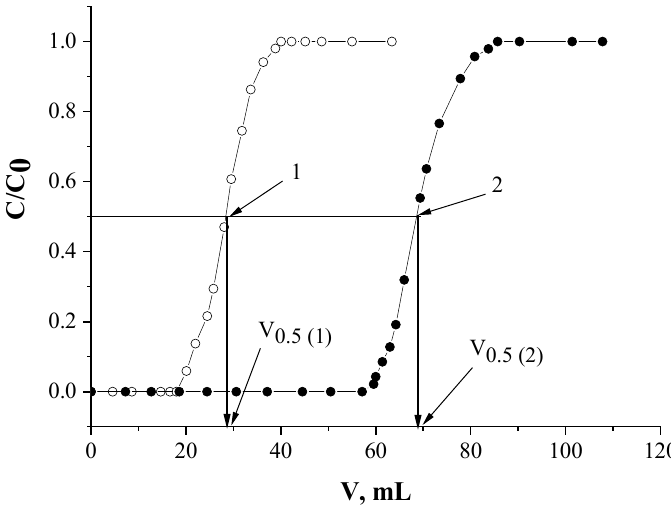
Figure 11. The approach of values calculation of metal distribution coefficients using frontal loading curves.